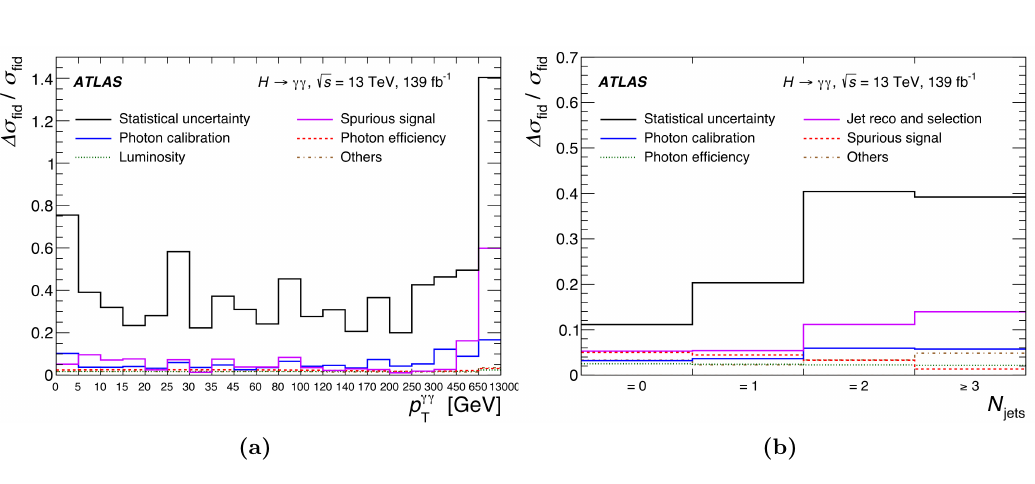
Figure 7. Summary of the uncertainties in the differential cross-section measurement for (a) p γγ (b) N . The five leading uncertainties are shown separately, while all other uncertainties (labelled jet as ‘Others’ in the figures) are summed in quadrature and shown as a single